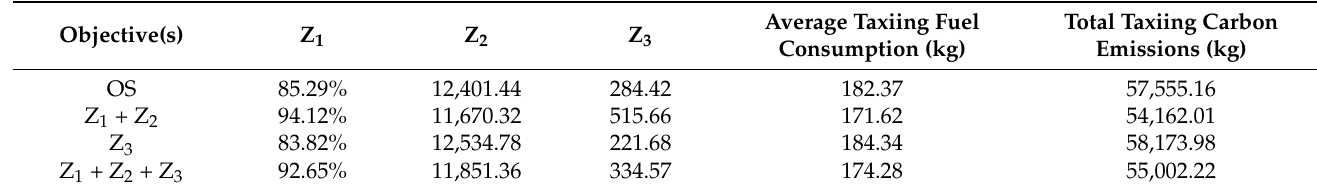
Table 4. Pareto front solutions based on the NSGA-II algorithm.